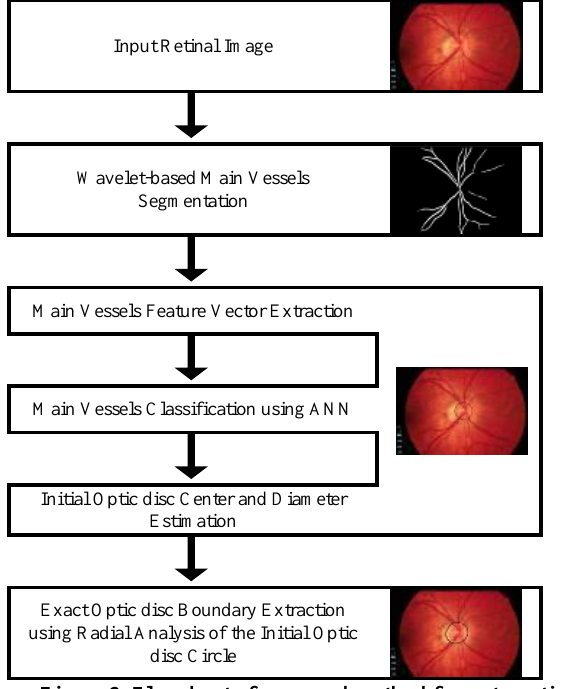
Figure 2. Flowchart of proposed method for automatic detection of center and boundary of optic disc.